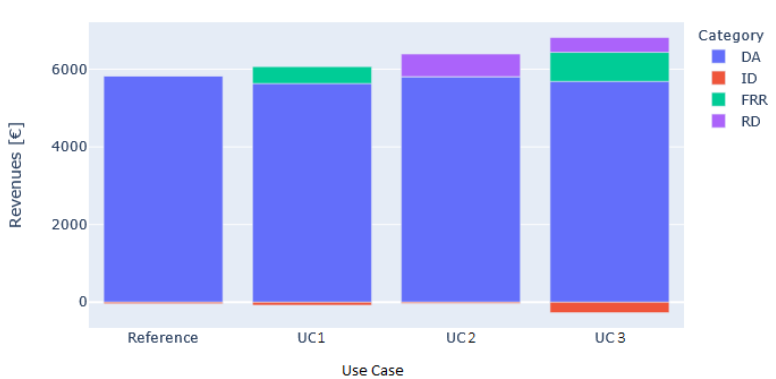
Figure 3. Comparison of cumulated revenues and costs for different use cases with the reference scenario (only trading at spot markets, day-ahead and intraday) exemplary for Zone West. For redispatch remuneration, nodal prices have been used. UC1: DA+FRR+ID, UC2: DA+Redispatch+ID, UC3: